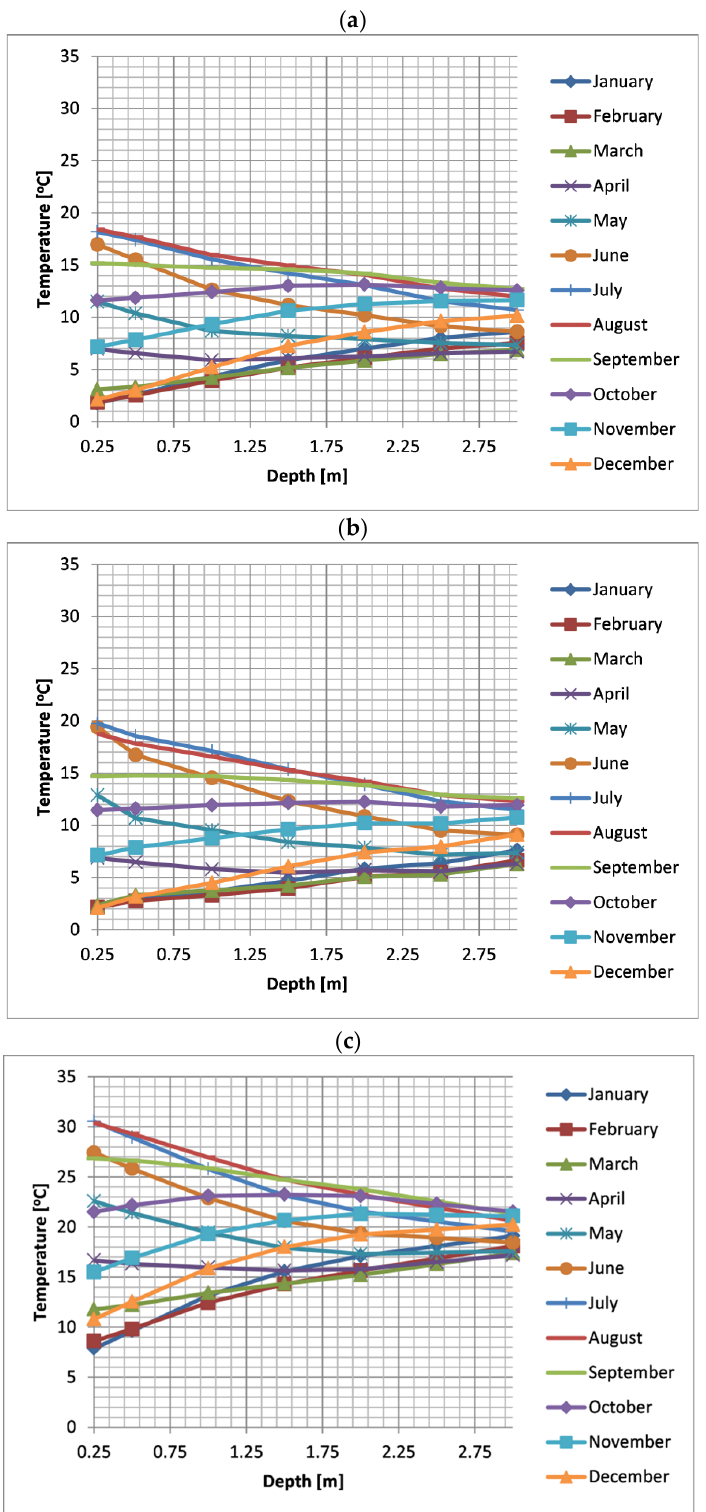
Figure 8. Average monthly temperatures as a function of depth for three measurement points: ( a ) No. 1, ( b ) No. 2, ( c ) No. 3.